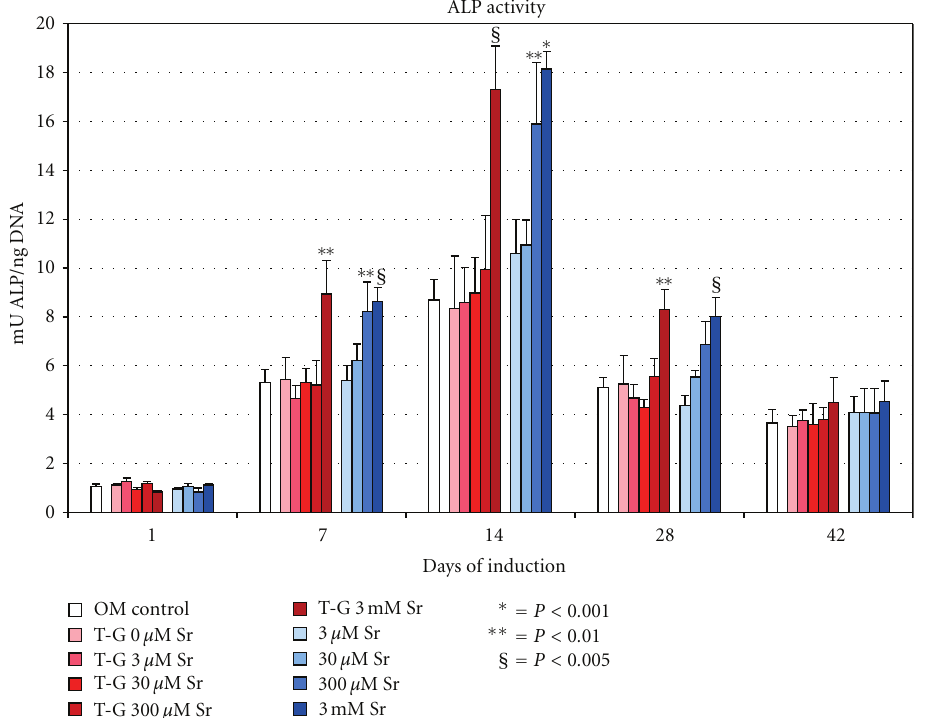
Figure 2: Quantitative analysis of ALP enzymic activity in PA2-E12 cultured on tPS from 1 to 42 days in OM in the presence of transwell con- taining CMCA hydrogel (T-G) enriched with scalar concentrations of strontium (T-G 0, 3, 30, 300 μ M and 3mM Sr 2+ ) or in OM only con- taining scalar concentrations of strontium (3, 30, 300 μ M and 3mM Sr 2+ ). The control is represented by cells cultured in OM without Sr 2+